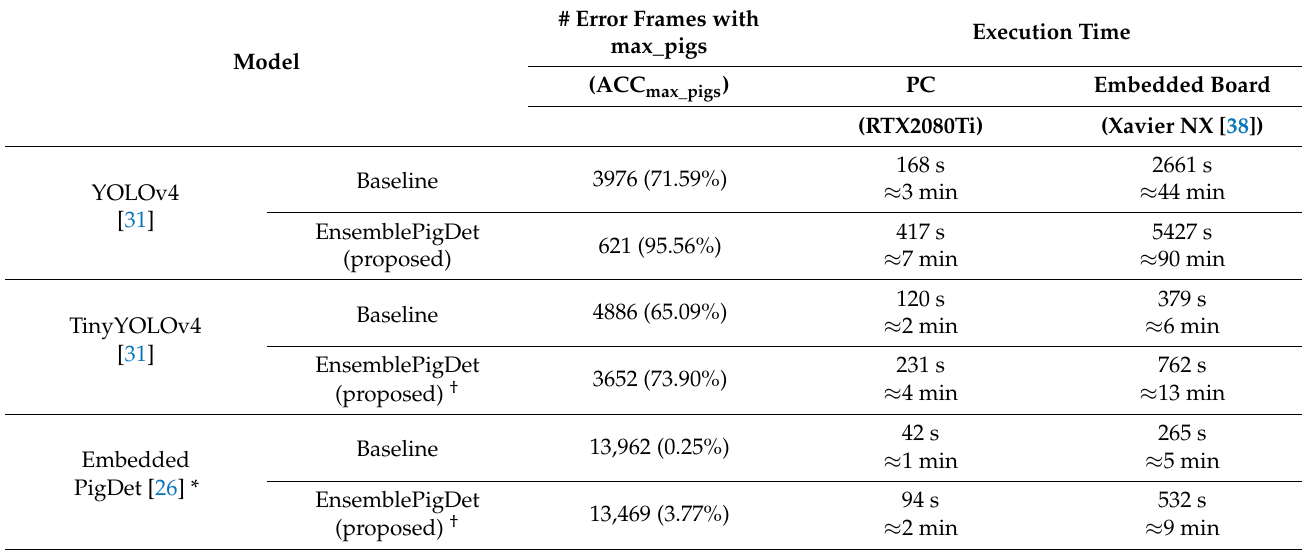
† : For the purpose of comparison, we used the parameters determined with baseline YOLOv4. *: For the purpose of comparison, we reimplemented EmbeddedPigDet [26] for grayscale images rather than composite